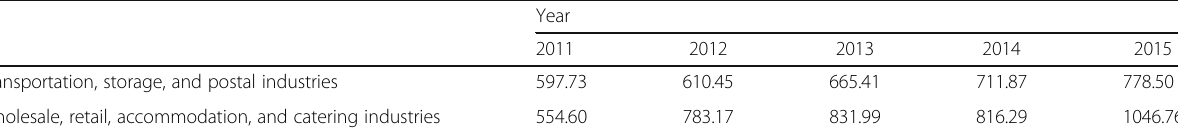
Table 1 Energy consumption (10,000 tons of standard coal)